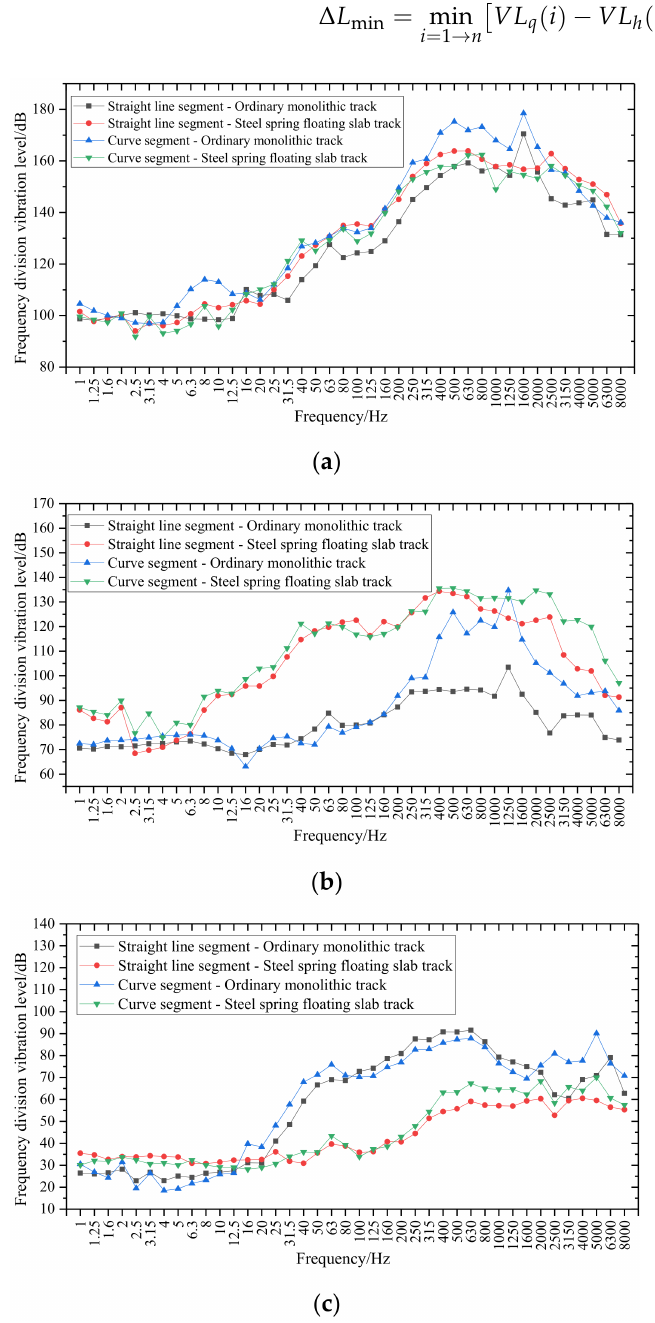
Figure 18. Comparison of frequency-division vibration levels of various rail components. ( a ) Rail; ( b ) track bed; ( c ) tunnel